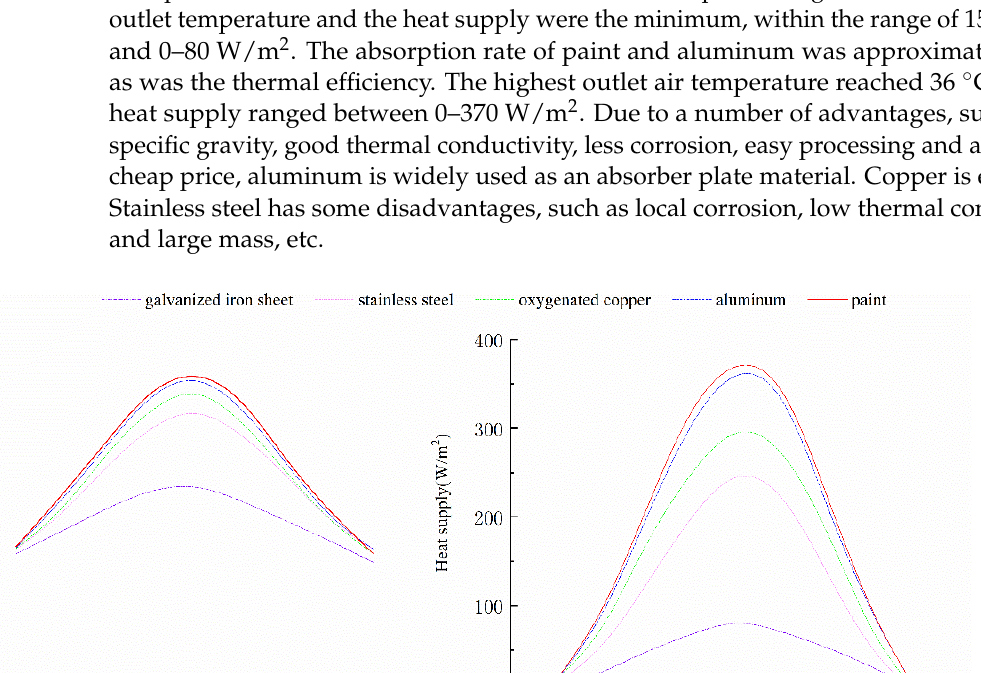
Table 6. Difference between the measured value and simulated value.